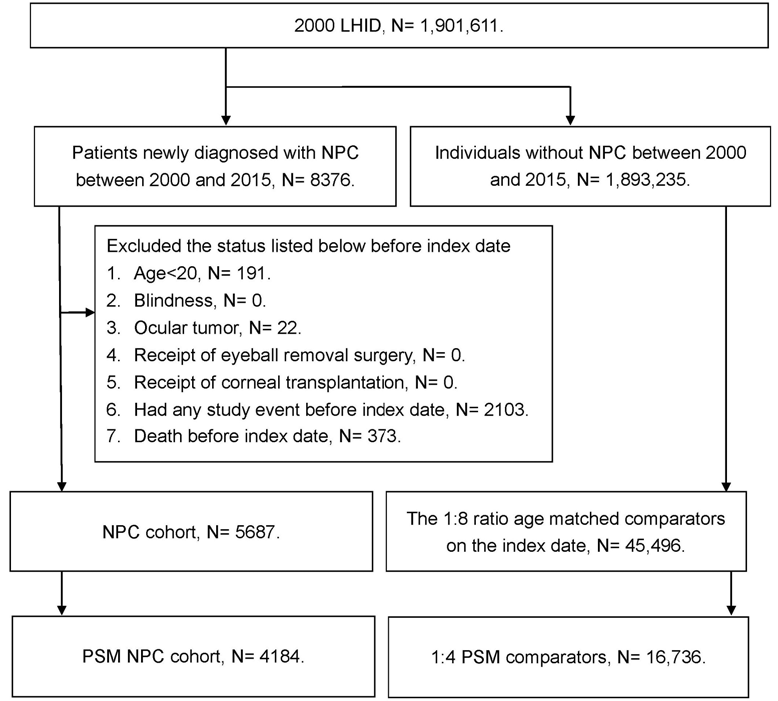
Figure 1. The flow chart of the patient selection. NPC: nasal pharyngeal carcinoma, N: number, PSM: propensity ‐ score matching.